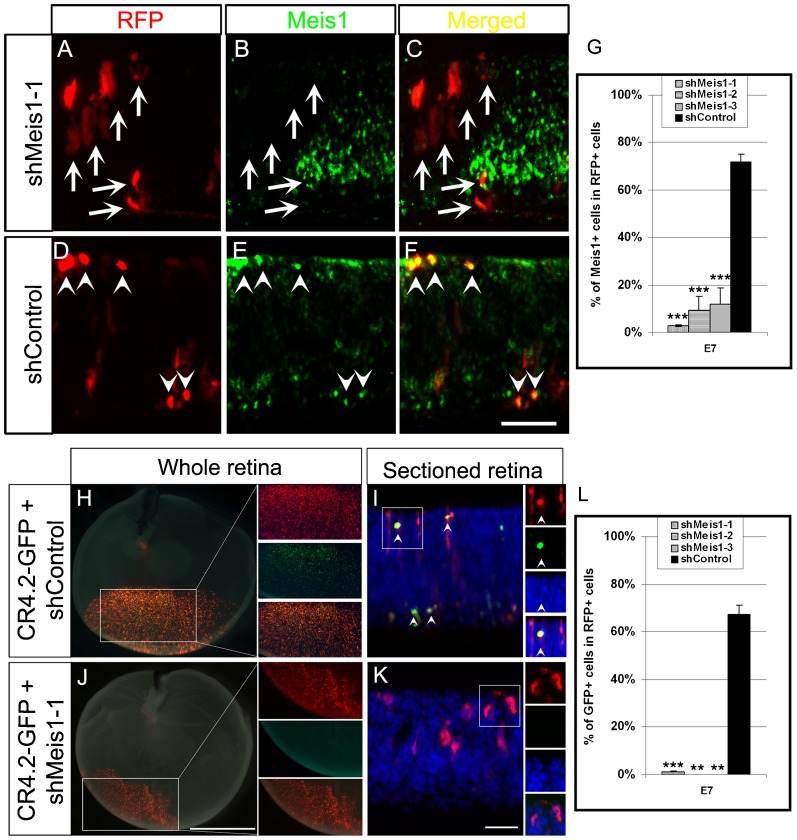
Knockdown of Meis1 abolishes CR4.2-GFP expression.(A–F) Chick retinas were electroporated with Meis1-1-shRNA-RFP (shMeis1-1) or Control-shRNA-RFP (shControl) plasmid at E4. Transfected retina tissues were harvested at E7, sectioned, and immunostained with Meis1 (green). RFP+ cells generated by shMeis1 transfection were observed with reduced protein level of Meis1 by antibody staining (arrows in panel B), but was unaffected by control shRNA transfection (arrowheads in panel E). A histogram (G) shows that there was a dramatic decrease in the percentage of Meis1+/RFP+ cells in shMeis1-1 group. Chick retinas were injected and electroporated with a mixture of CR4.2-GFP and either a shControl (H,I) or shMeis1-1 (J,K) on embryonic day 4 (E4). Transfected retinas were examined for reporter GFP expression at E7. GFP+ cells were observed in the transfected retinas from shControl (H,I) but not from shMeis1-1 (J,K). Double labeled cells are indicated by arrowheads, while arrows represent cells that are not co-labeled. (L) Quantification of RFP+ cells that coexpress GFP. Error bars represent standard error of the mean. Each histogram represents the mean ± s.d.; n≥3. ONL, outer nuclear layer; INL, inner nuclear layer; GCL, ganglion cell layer. Scale bars: 20 µm.